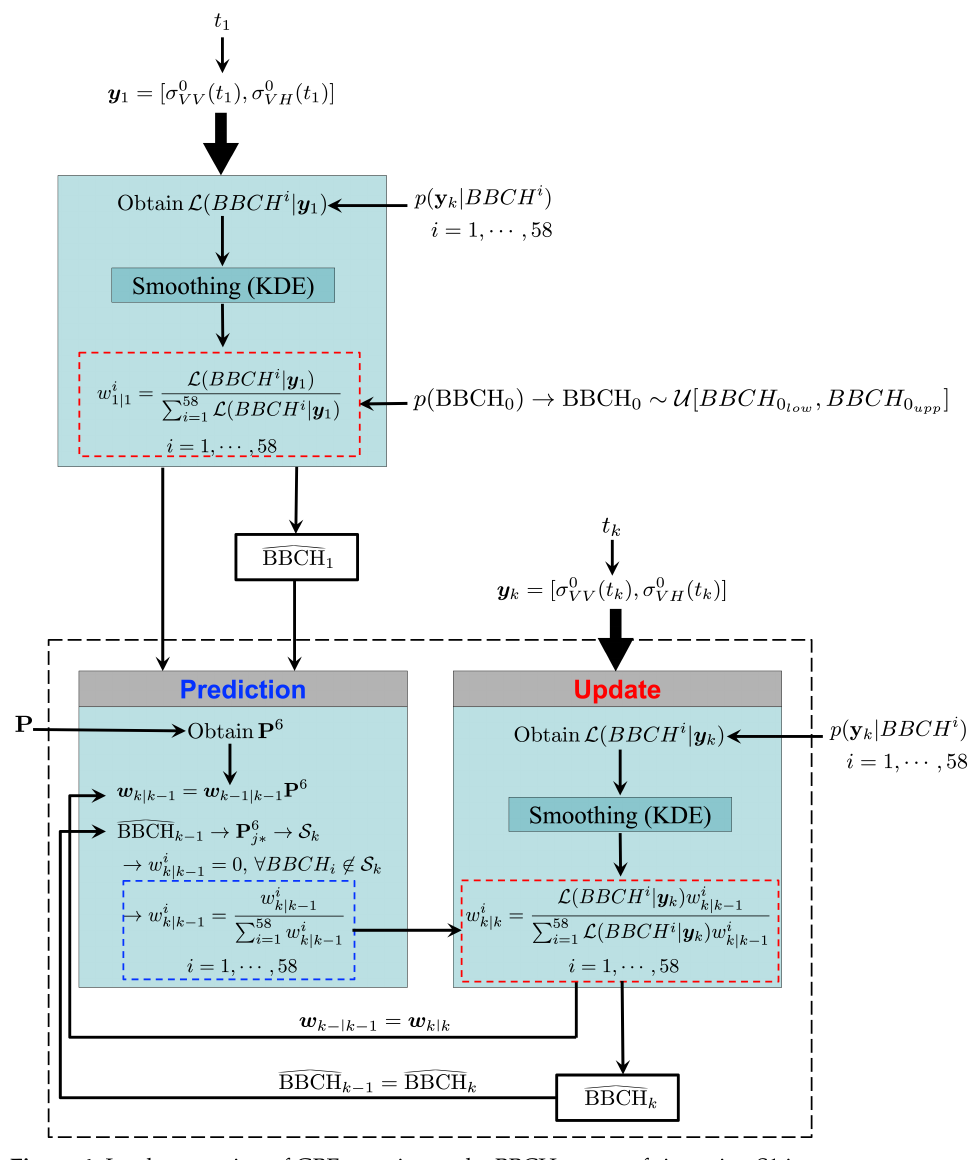
Figure 4. Implementation of GBF to estimate the BBCH stages of rice using S1 images. (cid:92) Once that the k − 1th estimation is provided, both BBCH k − 1 and the vector w k − 1 | k − 1 serve as inputs for the prediction step. Here, the prediction model P is used to define the 6-day transition matrix P 6 (11). Then, once the weights at t k are predicted (12), the j th P 6 (cid:92) row (13) corresponding to BBCH k − 1 is used to determine S k (14). Successively, unrealistic stages are excluded and the weights normalized (6). = [ σ 0 ( t ) , σ 0 ( t )] . This, At time t k , a new S1 acquisition results in the vector y k k k VV VH along with the observation model p ( y k | BBCH i ) , is used as an input at the update step to ) (16). The latter is first smoothed with KDE, and then, obtain the likelihood L ( BBCH i | y k by applying (7), is used to update the weights obtained at the prediction step. Finally, ) (8), allow the resulting weights w i , which in turn yield the posterior pdf p ( BBCH k | y 1: k k | k (cid:92) obtaining the k th BBCH estimate (9), BBCH k